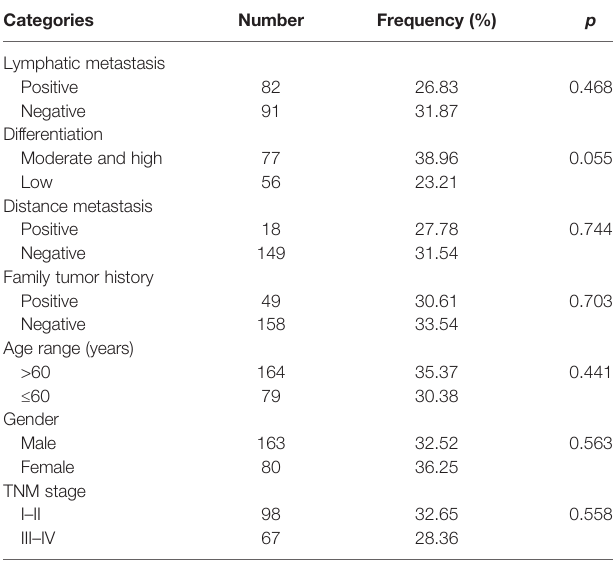
TABLE 3 | The positive frequencies of anti-GNA11 autoantibody in subgroups.